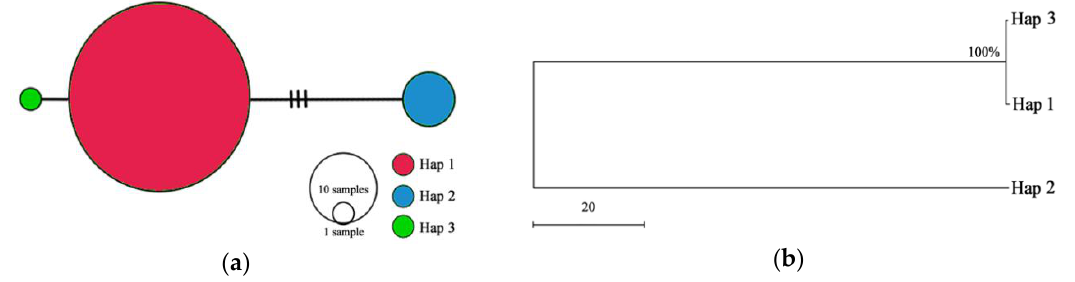
Figure 5. Analysis of cpDNA haplotypes: ( a ) Network of 3 cpDNA haplotypes (Hap 1–Hap 3), ( b ) Phylogenetic relationship of 3 haplotypes based on the Maximum Parsimony (MP) method analysis.